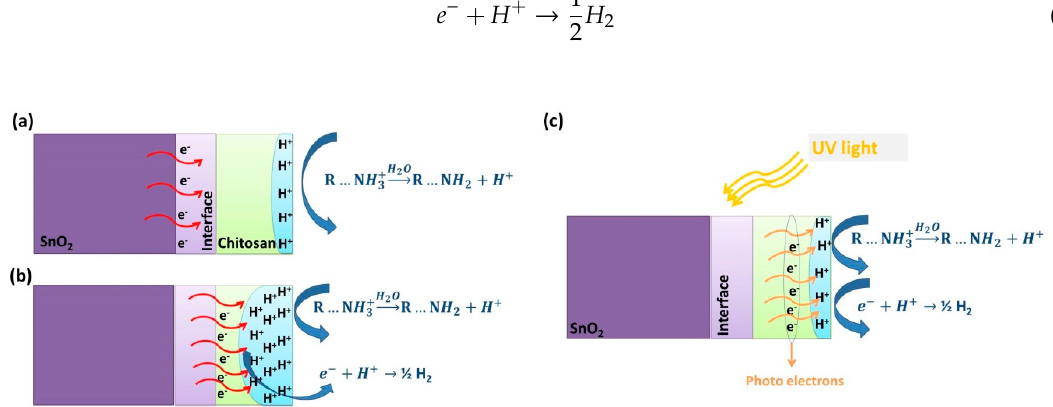
Figure 9. The humidity-sensing mechanism of hybrid chitosan@SnO 2 nanowires ( a ) in a low level of humidity, ( b ) in a high level of humidity, and ( c ) under UV irradiation. The dual conduction was not observed in 25% RH. This observation indicates that there is a threshold RH value between 25–50% RH to activate valance electrons of SnO 2 .